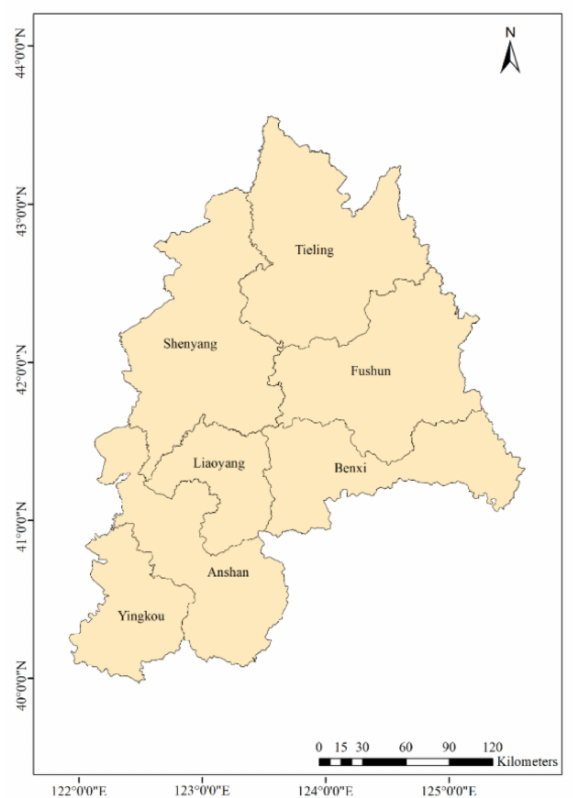
Figure 1. The Central Liaoning Urban Agglomeration (CLUA) and its